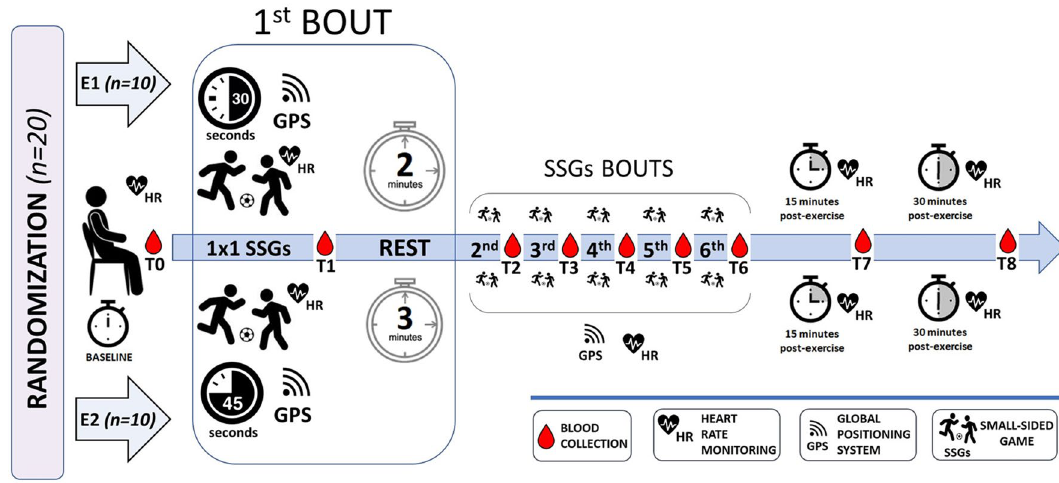
Figure 1. Experimental protocol. SSGs—small–sided games; E1—6 × 30 s 1 × 1 SSGs; E2—6 × 45 s 1 × 1 SSGs; HR—heart rate; GPS—global positioning system. Group E1 Variable (n =